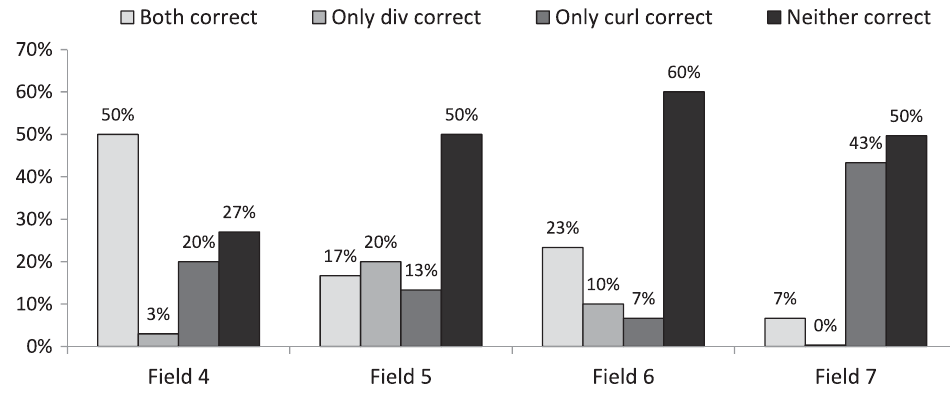
FIG. 1. Results for the question about graphical representations of vector fields on the pretest ( N ¼ 30